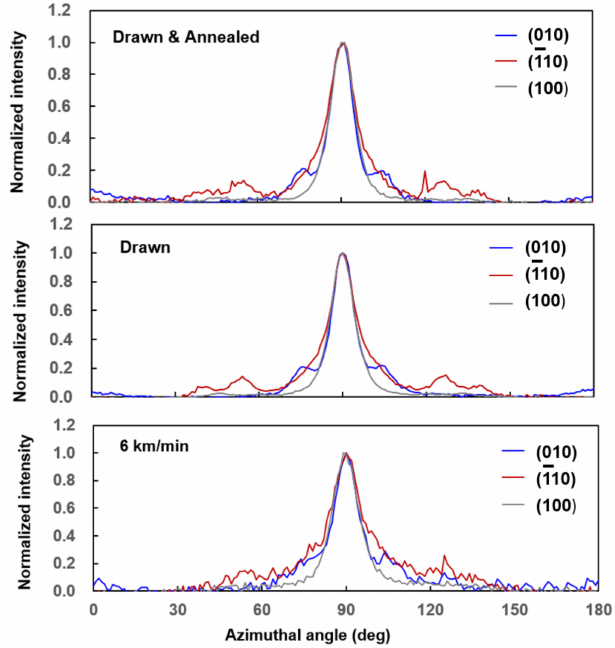
(cid:0) (cid:1) 110 , and (100) reflections of high-